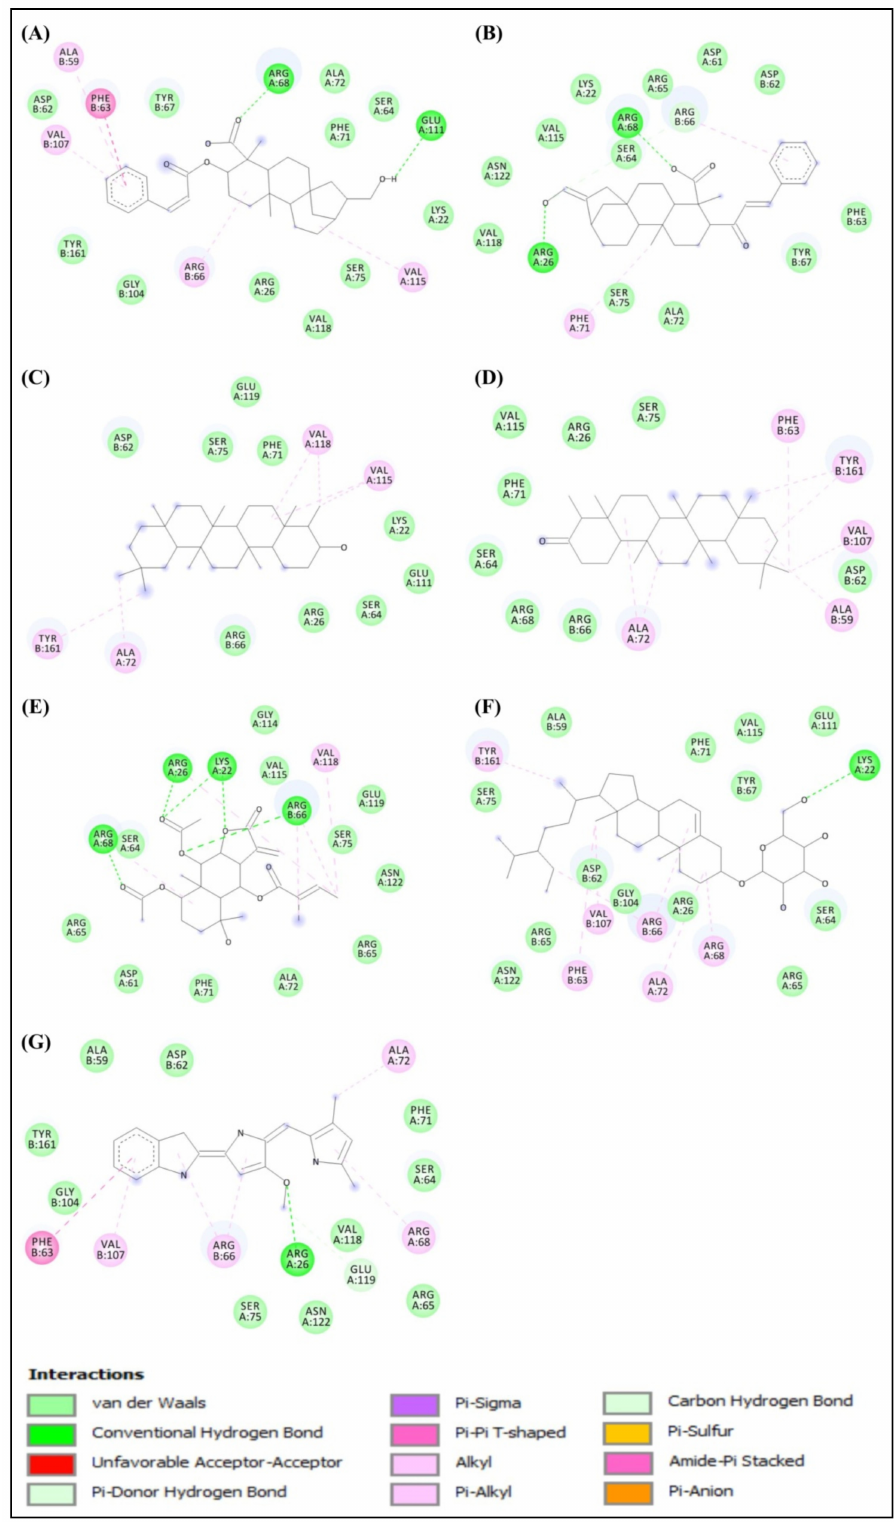
Figure 5. Two-dimensional illustration of the interaction of Bcl-2 protein with the top potential phytochemicals from W. trilobata and standard drug. ( A ) Wedelidin A; ( B ) Wedelidin B; ( C ) Friedelinol; ( D ) Friedelin; ( E ) Trilobolide 6-O-angelate; ( F ) Daucosterol; and ( G ) Obatoclax. Generally, a good inhibitor has a sufficient number of hydrogen bonds and other hydrophobic interactions, which are very important for protein–ligand interactions